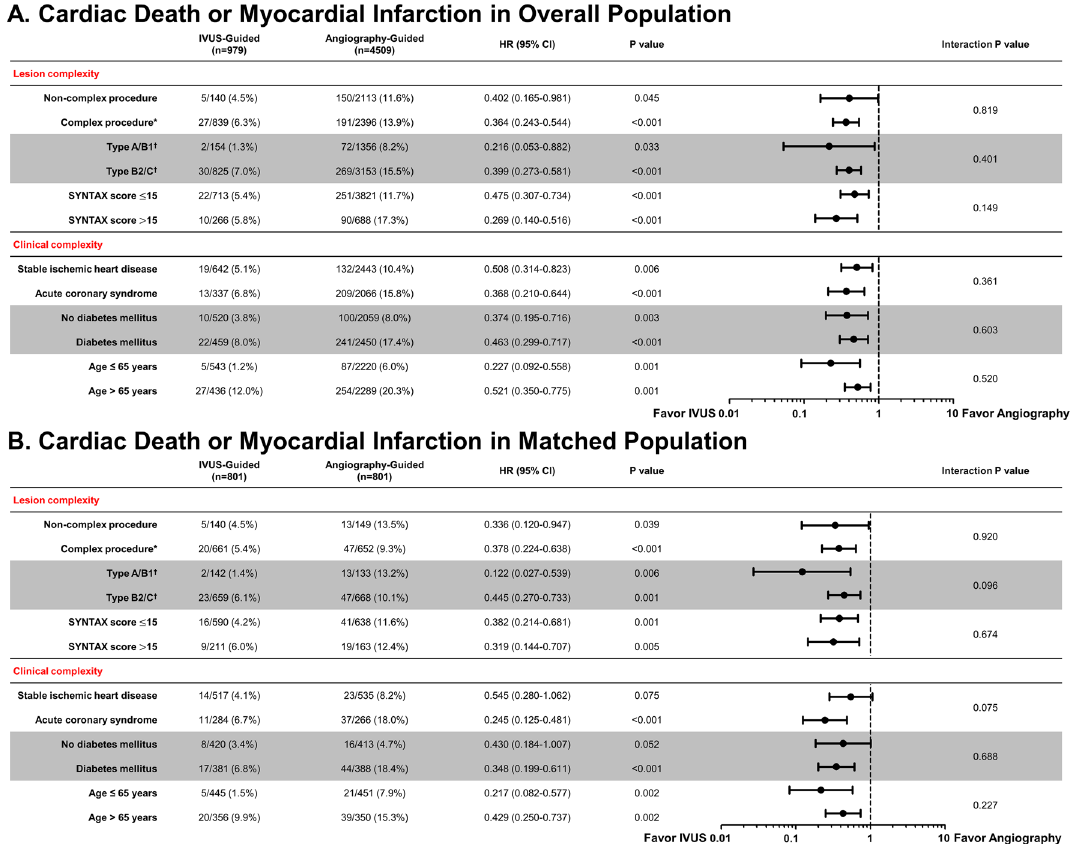
population ( A ) and matched population ( B ) between IVUS- versus angiography-guided PCI. *Complex procedure is defined as bifurcation, chronic total occlusion, left main disease, long lesion, multivessel PCI, multiple stent implantation, in-stent restenosis, or heavily calcified lesion. † AHA/ACC lesion classification.